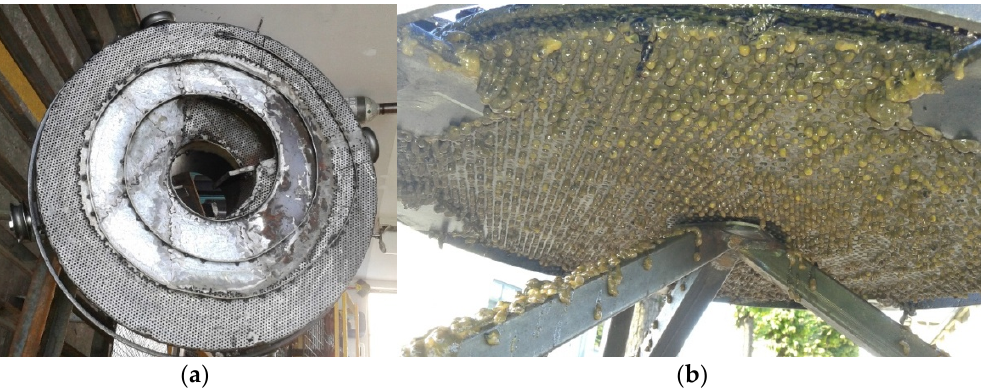
Figure 6. The final prototype: ( a ) collection chamber below the feed window and a single spiral conveyor bulkhead working chamber; ( b ) extrusion of pitted pulps.